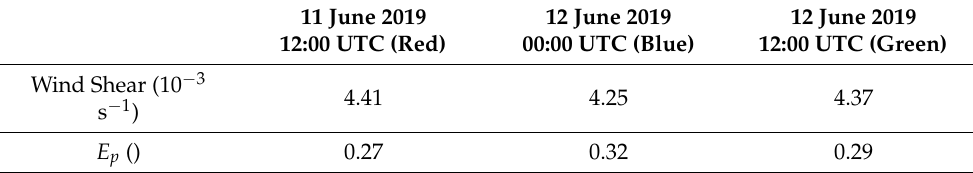
Figure 5. Precipitation efficiency as a function of the wind shear, modified after [48]. Table 4. Wind shear and precipitation efficiency for the three radio